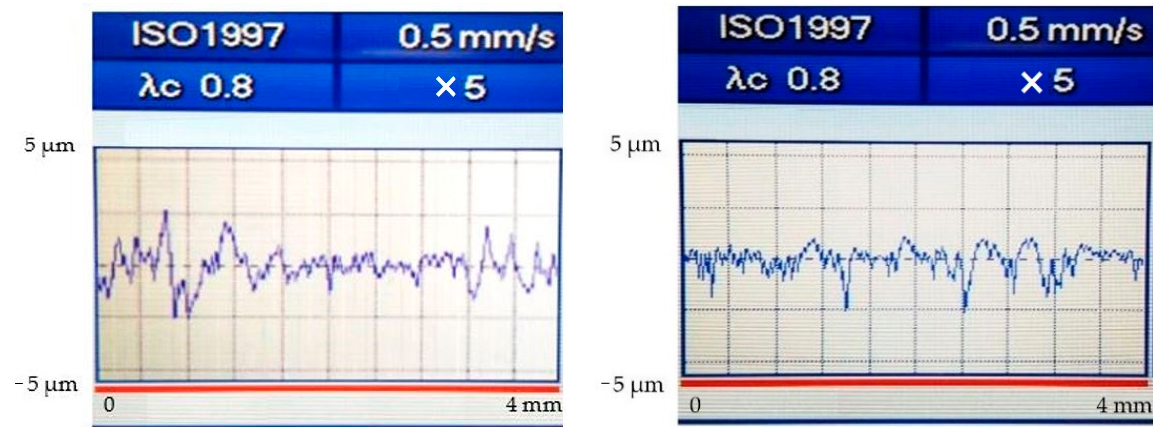
Figure 7. Examples of the surface roughness of the samples subjected to solution treatment ( left ) and nitrided ( right ), tested for cavitation erosion for 165 min.